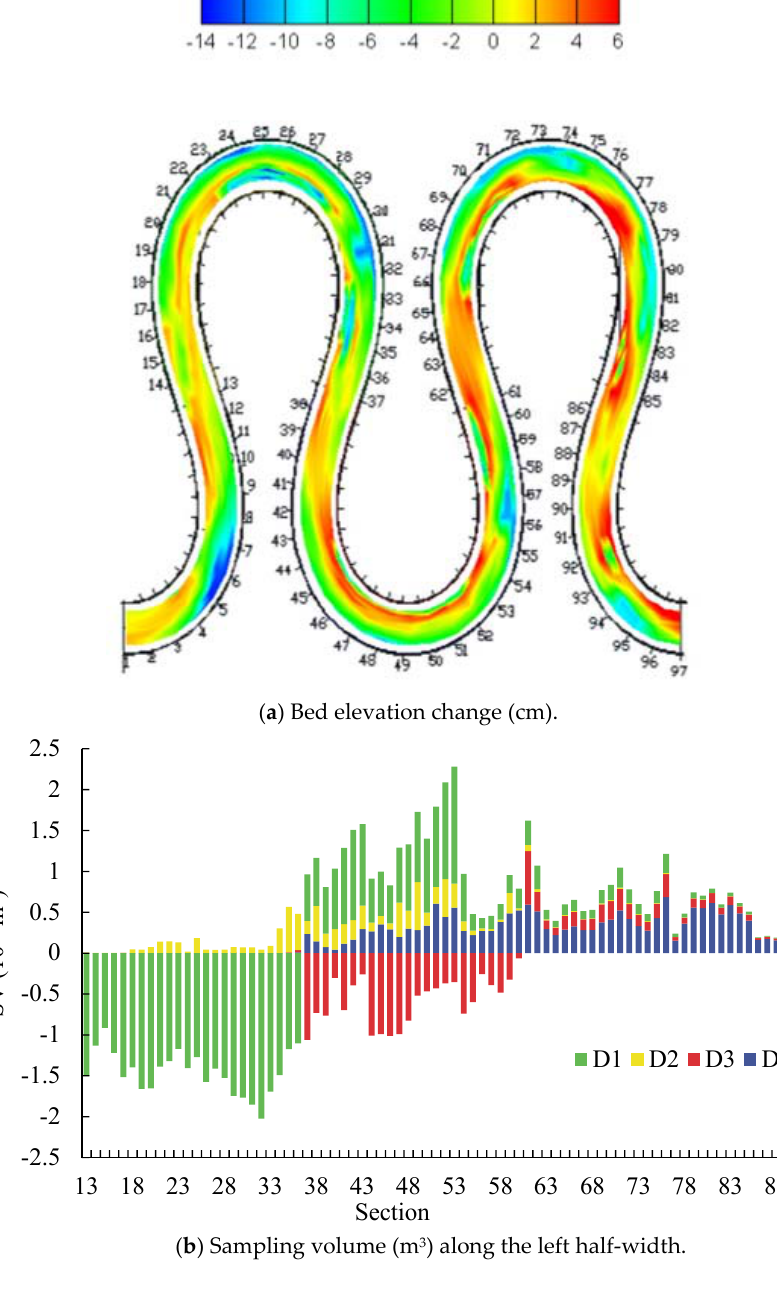
( b ) Sampling volume (m 3 ) along the left half-width. Figure 2.